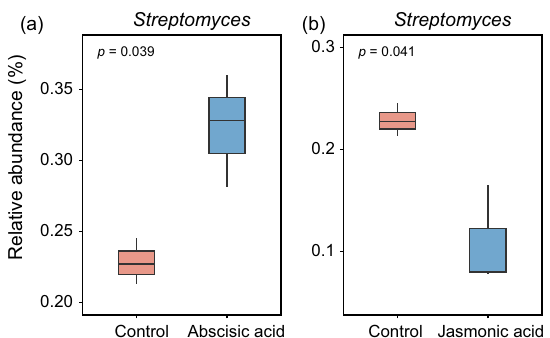
Fig. 8 Changes in relative abundance of specific bacterial genera following the addition of selected a abscisic acid and b jasmonic acid under drought stress. The center lines of the boxes indicate the medians, the top and bottom of the boxes indicate the first and third quartiles, and the whiskers indicate the 1.5 interquartile range. The p -values are calculated by